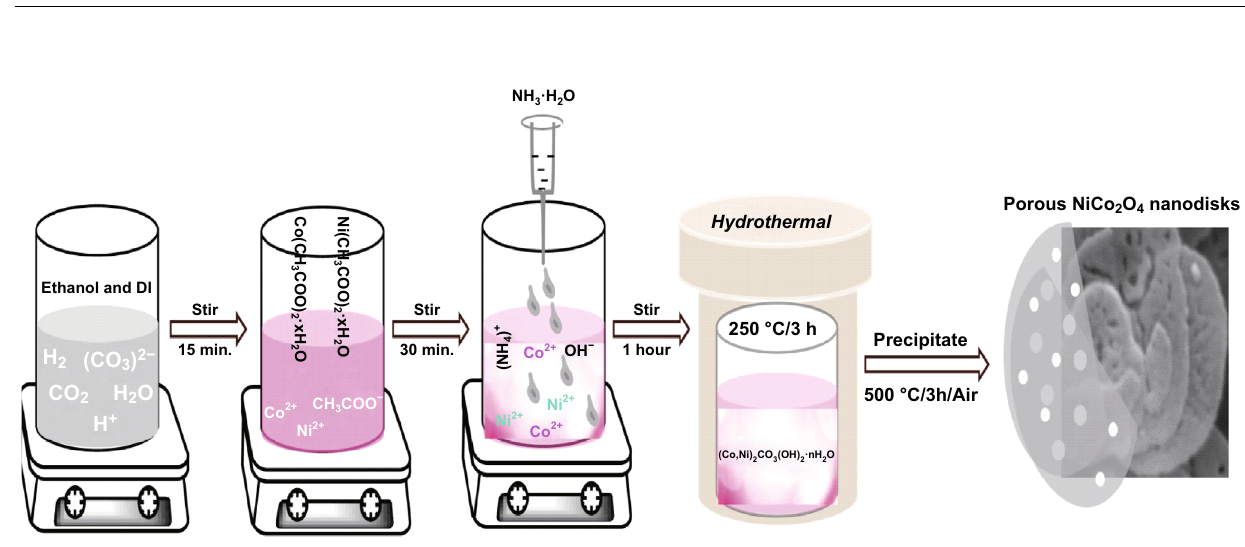
Fig. 4 Schematic diagram for the synthesis of two-dimensional porous nanodisks of NiCo 2 O 4 . Reproduced with permission from Ref. [114], Copyright © 2018 Elsevier